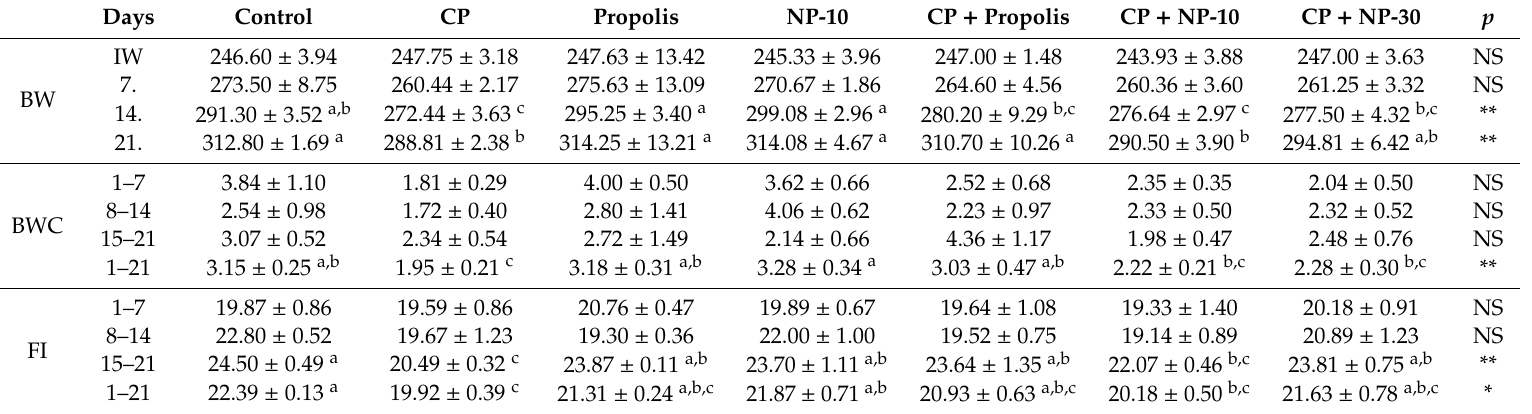
Table 1. E ff ects of propolis and nano-propolis on body weight (BW—g / rat), body weight change (BWC—g / rat / day) and feed intake (FI—g / rat / day) of the experimental groups (Mean ±